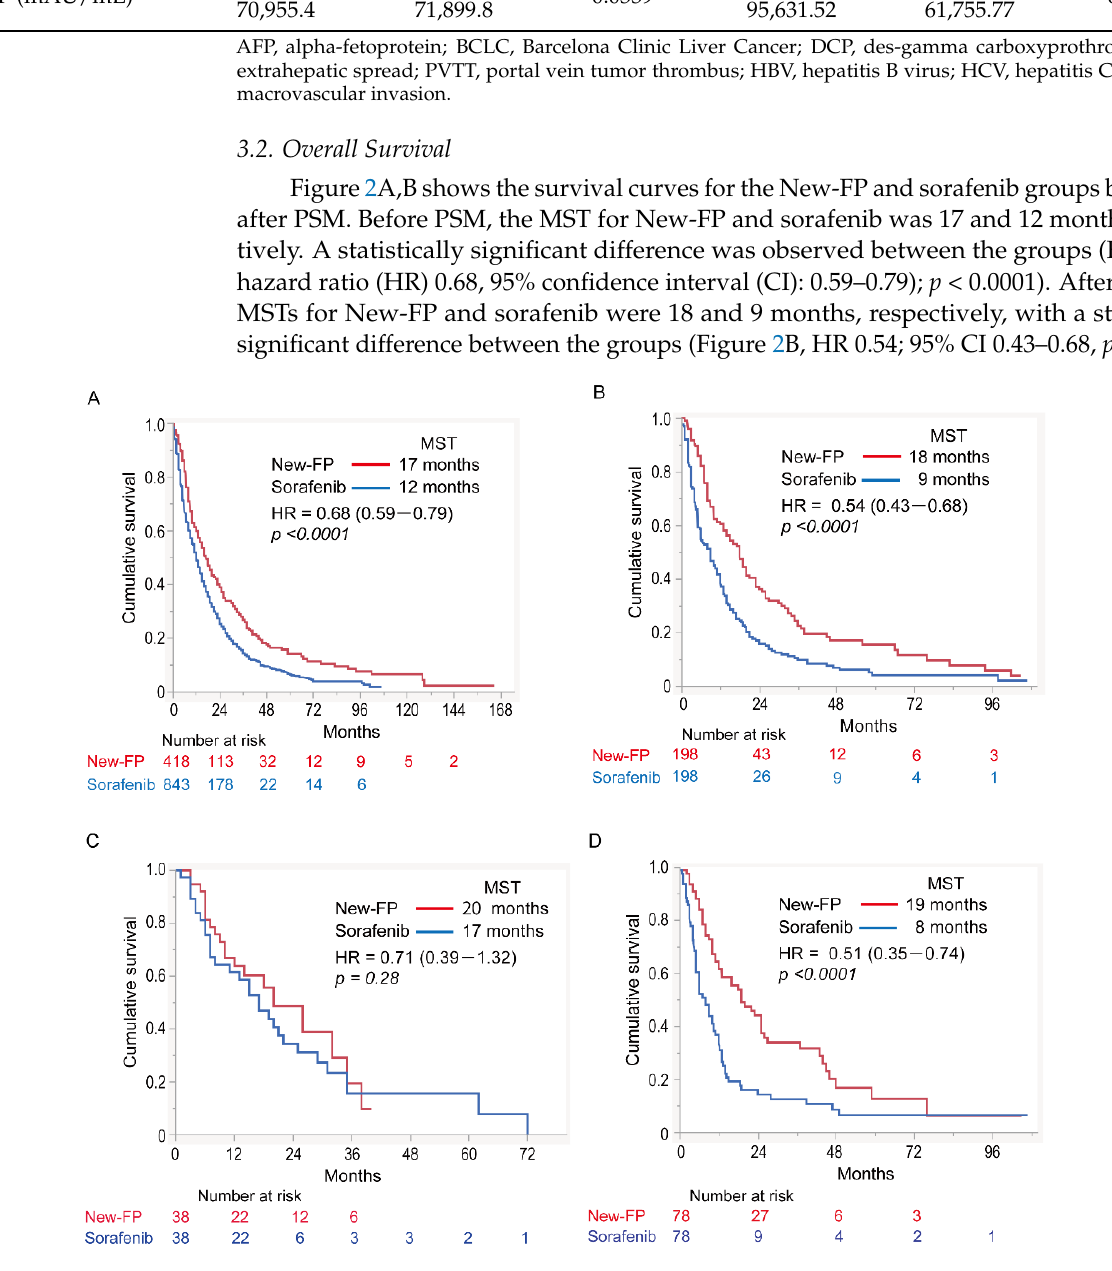
Figure 2. Overall survival curves for patients in the New-FP and sorafenib groups. (A) New-FP ( n = 418, red line) and sorafenib ( n = 844, blue line), before propensity score matching. (B) New-FP ( n = 198, red line) and sorafenib ( n = 198, blue line), after propensity score matching. (C) Cohort 1 (no MVI or EHS), New-FP ( n = 38, red line) and sorafenib ( n = 38, blue line). (D) Cohort 2 (MVI with no EHS), New-FP ( n = 78, red line), and sorafenib ( n = 78, blue line). (E) Cohort 3 (EHS with no MVI), New-FP ( n = 6, red line), and sorafenib ( n = 6, blue line). (F) Cohort 4 (MVI and EHS), New-FP ( n = 78, red line), and sorafenib ( n = 78, blue line). HR, hazard ratio; MST, median survival time; New- FP, fine-powder cisplatin and 5-fluorouracil; EHS, extrahepatic spread; MVI, macrovascular inva- sion. 3.3. Prognostic factors After applying PSM, prognostic factor analyses were performed for the entire dataset (Table 2). A Child – Pugh score of 5, the presence of major PVTT, the presence of EHS, the